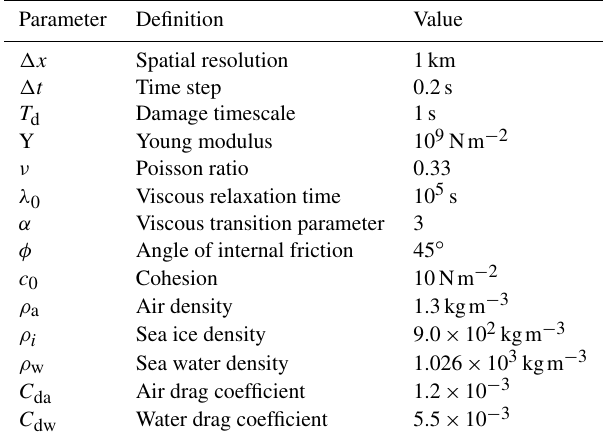
Table 1. Default model